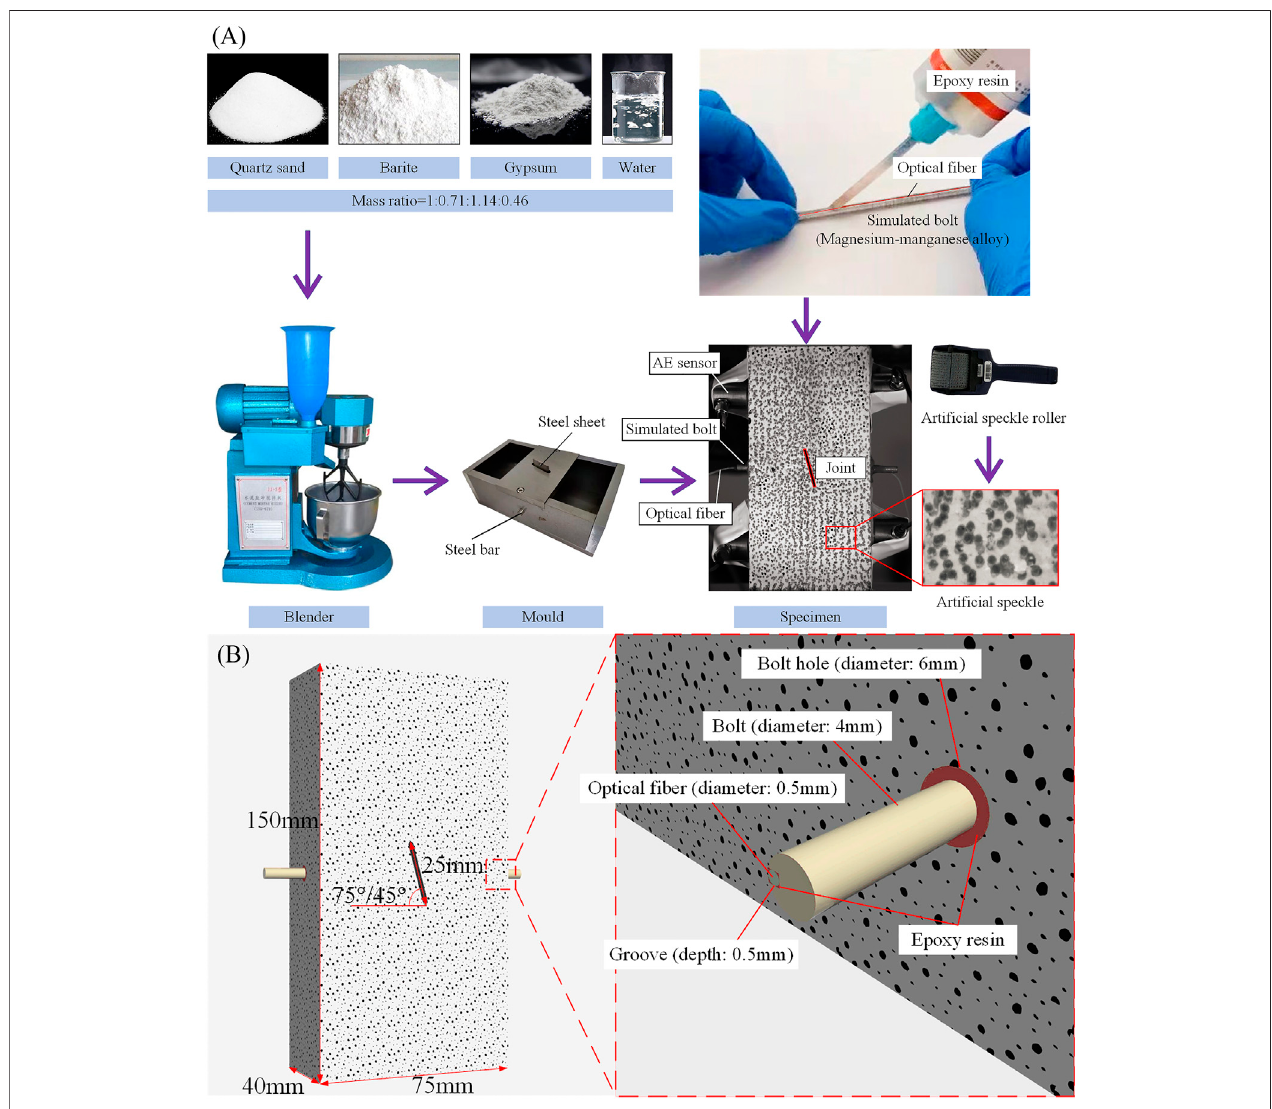
FIGURE 1 | Bolted jointed specimen production process (A) and size (B)